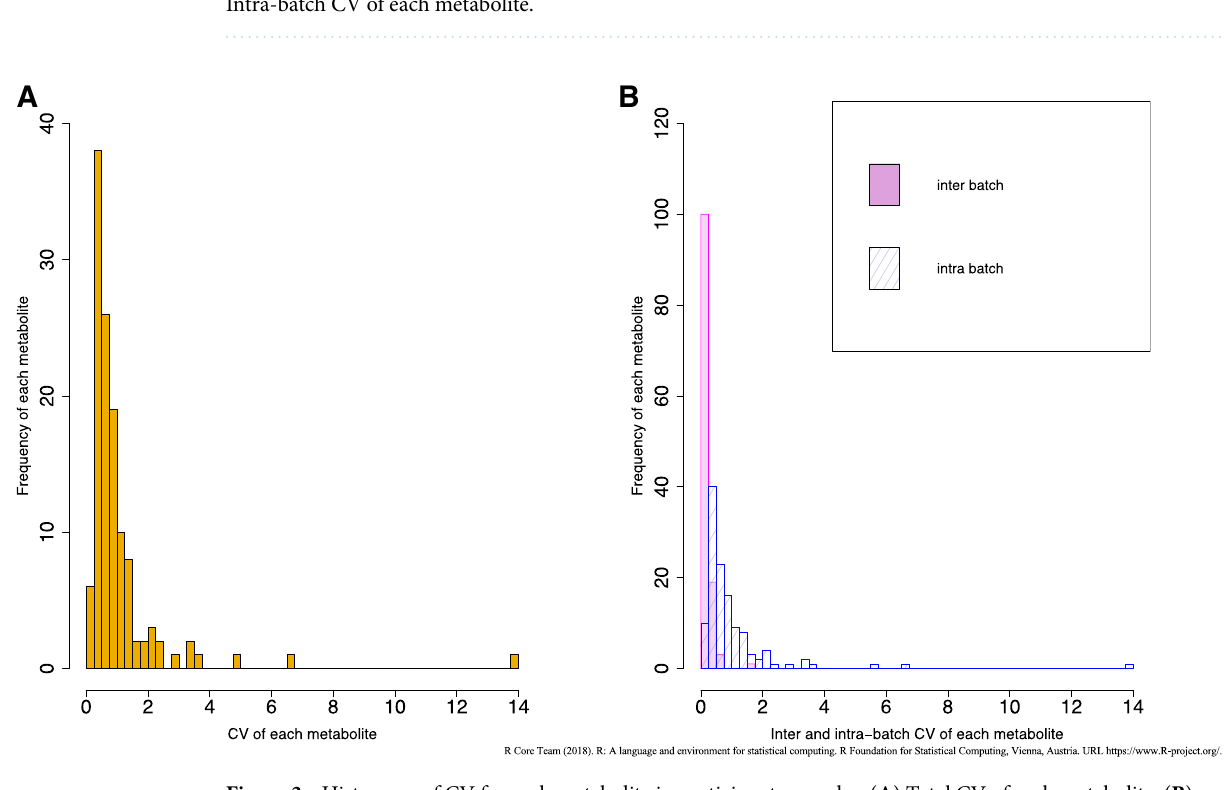
Figure 2. Histogram of CV for each metabolite in QC samples. ( A ) Total CV of each metabolite. ( B ) Inter and Intra-batch CV of each metabolite.